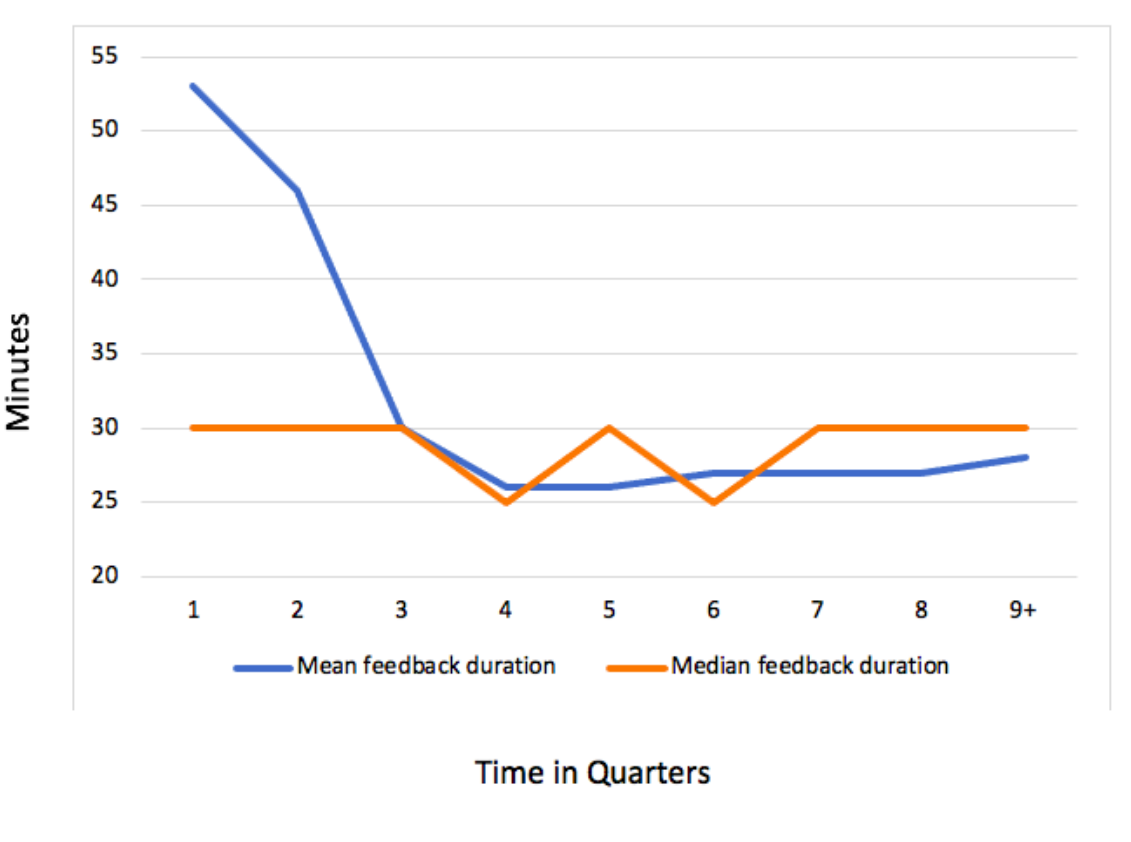
Figure 1. Feedback duration across intervention quarters. Counselor efficiency increases over